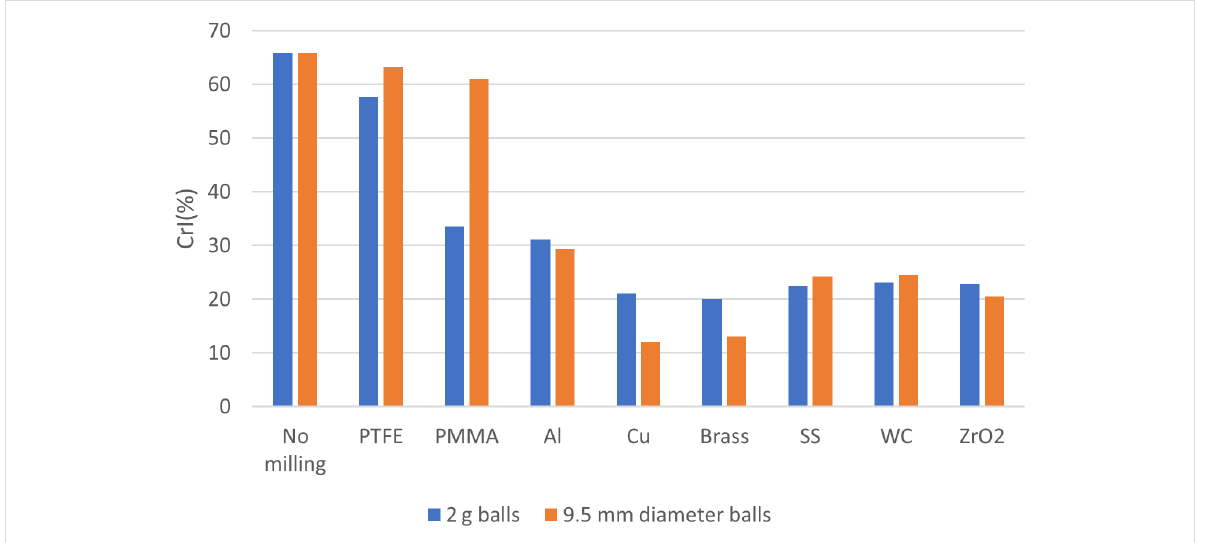
Figure 1: CrI% for chitin samples, before and after milling in a jar with one ball made of SS, ZrO 2 , Cu, Al, brass, WC, PMMA, PTFE. One series has ball mass = 2 g (blue) and one ball diameter = 9.5 mm (in orange). Experimental conditions: 200 mg of chitin, milling time: 30 min, milling frequency 29.5